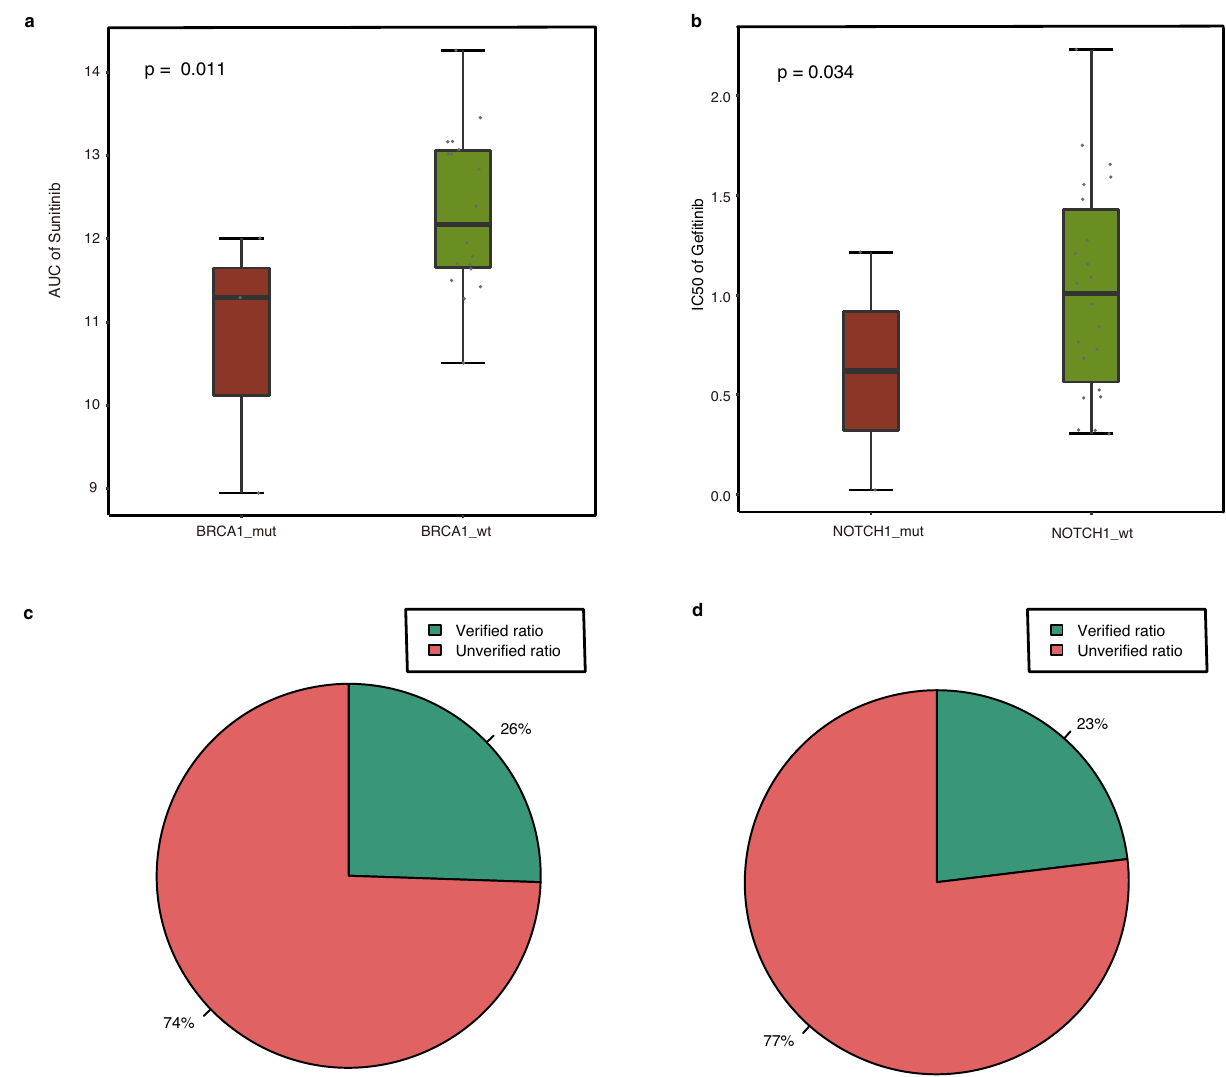
Fig. 4 In vitro pharmacologic evidence. Boxplot of the one-sided Wilcoxon rank sum test based on SL (AUC) ( a ) or SDL (IC 50 ) ( b ). Box plots indicate median (middle line), 25th, 75th percentile (box), and 5th and 95th percentile (whiskers) as well as outliers (single points), n = 42 independent experiments in SL (AUC) ( a ) and n = 144 independent experiments in SDL (IC 50 ); Dots represent cancer cell lines. Statistics of validations (green) and non-validations (red) in SL ( c ) or SDL ( d